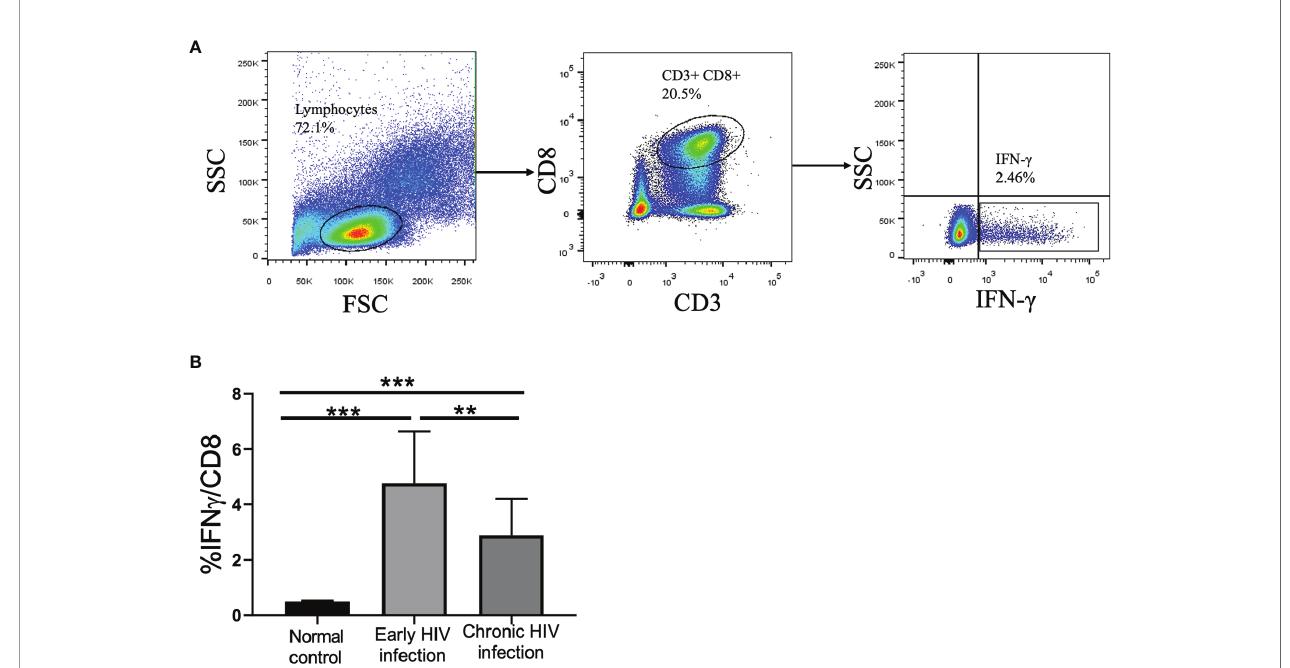
FIGURE 3 | Frequency of IFN- g -producing CD8+ T cells in normal controls, early HIV infection, and chronic HIV infection groups. (A) The gating strategy for fl ow cytometric analysis of IFN- g -producing CD8+ T cells. (B) Comparison of the proportion of IFN- g -producing CD8+ T cells. The signi fi cance of differences was assessed by calculating P values in Mann – Whitney tests. ** p <0.01, *** p